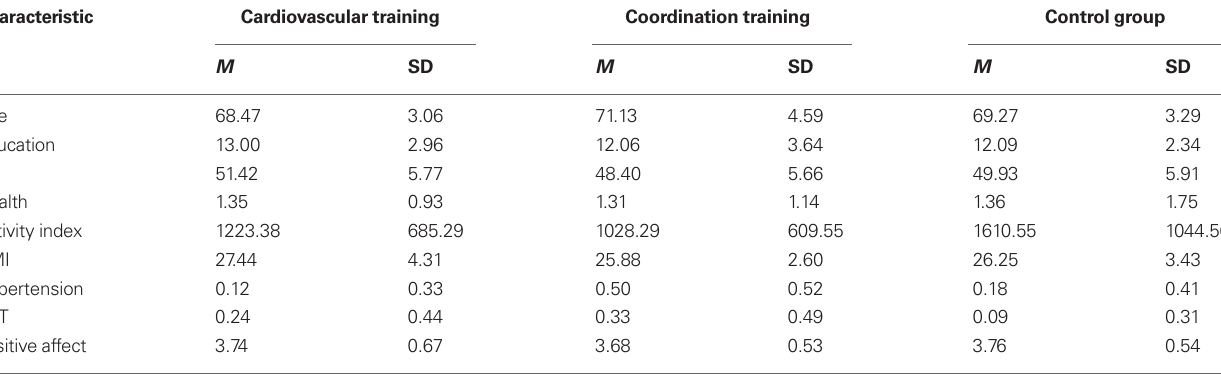
Table 1 | Demographic information for participants of the two experimental groups (cardiovascular and coordination training) and the control group.